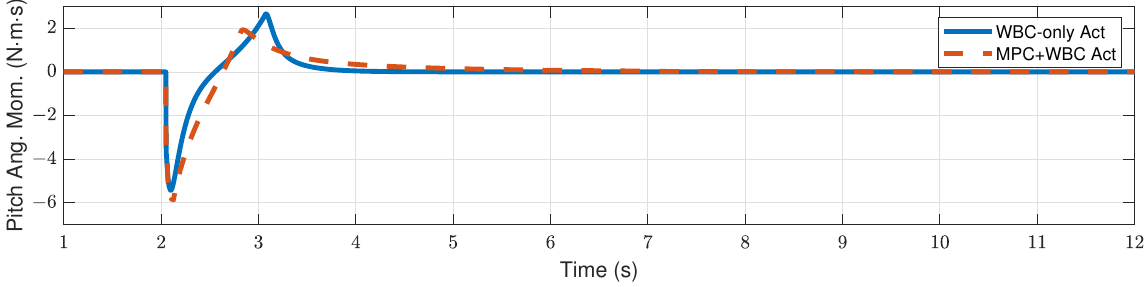
Figure 9. Centroidal pitch angular momentum of the robot under the frontal impact of a 9 kg rigid